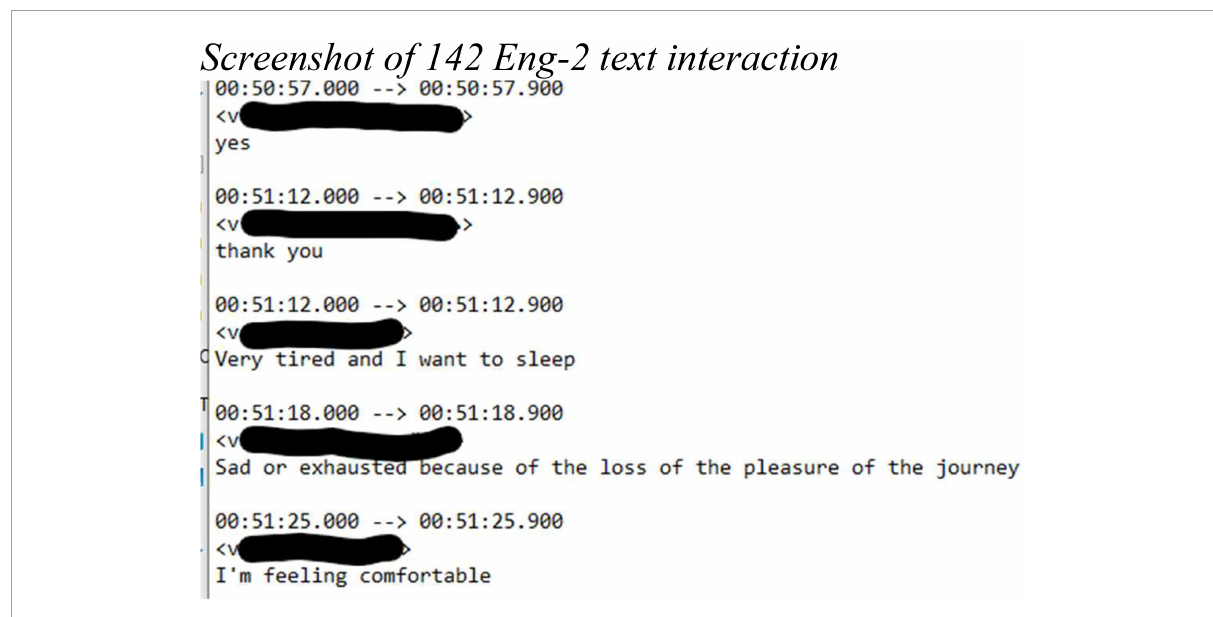
FIGURE7 Screenshot of 142 Eng-2 text